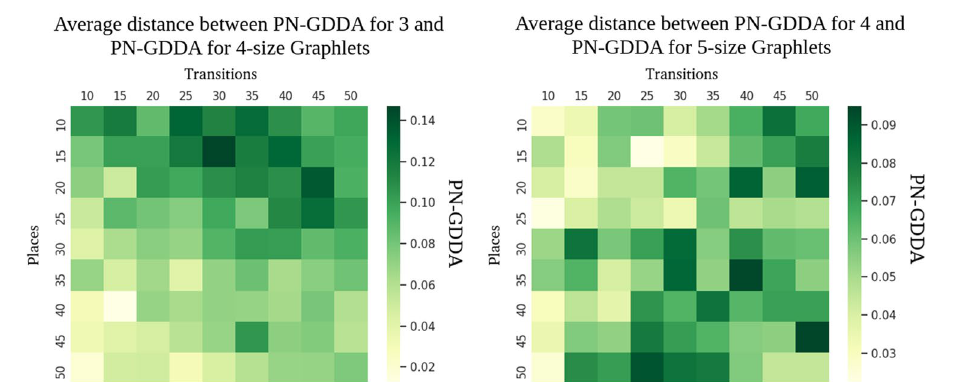
Figure 10. Three diagrams representing results of test determining average values of GDDA (100 nets per case) when pn-graphlets of different sizes are used. Data used for diagrams can be found in Tables S1–S3 from supplementary material. (All diagrams have been created using Seaborn library—v0.11.2—https:// seabo rn. pydata. org) 20 .